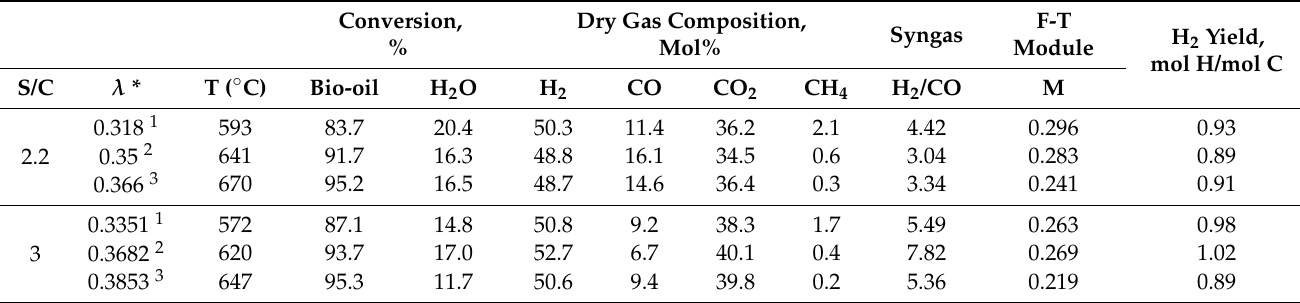
Table 9. Conversion and product distribution for ATR of bio-oil at S/C ratios of 2.2 and 3 for different air flows at 1 bar, includes Fischer–Tropsch H 2 /CO and module M